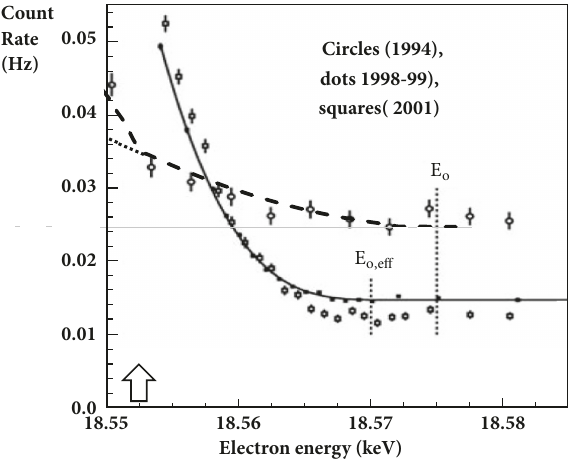
Figure 4: The published data for the Mainz Collaboration taken during different years as it appeared in [19]. The solid curve was their 𝑚 = 0 fit to the 1998-99 data. The dashed 3+3 curve has been added after adjusting the background level and the vertical scale so as to fit the 1994 data. The Mainz data from later years do not show the predicted kink (at the location of the up arrow), because they Mainz did not publish their data beyond 20 eV from the spectrum endpoint in those